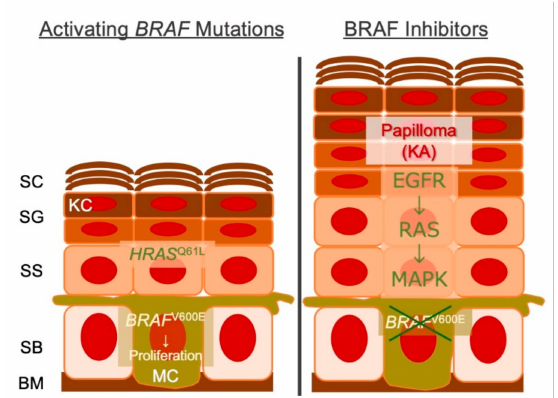
Figure 2. Schematic representation cSCC/KAs secondary to BRAF inhibition. Melanocytes with BRAF V600E/K (or other mutations) are sensitive to the targeted therapy, whereas KC with HRAS Q61L (or other mutations) are not. BM, basement membrane; SB, stratum basale; SS, stratum spinosum; SG, stratum granulosum; SC, stratum corneum; KC, keratinocyte; MC, melanocyte; KA,